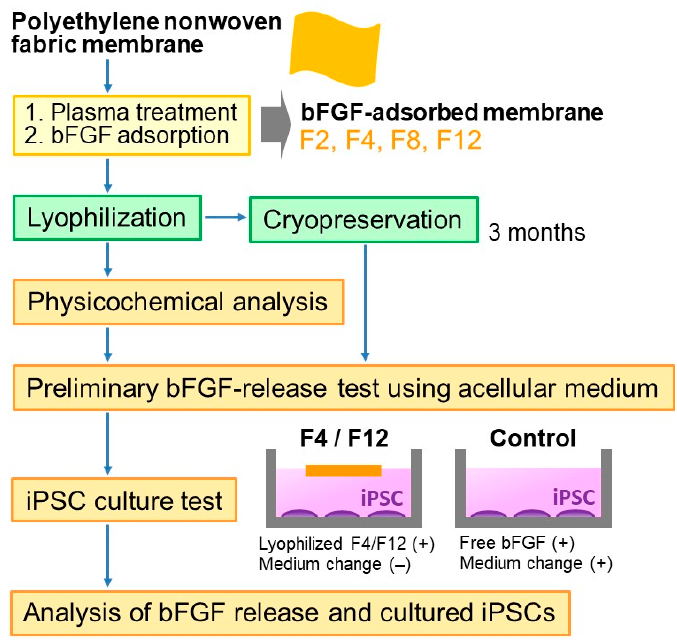
Figure 1. Experimental